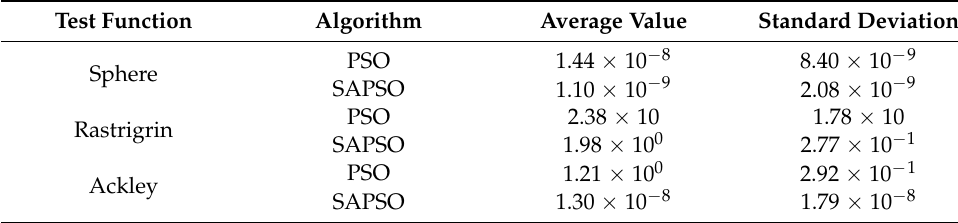
Table 2. Optimization results of different algorithms.